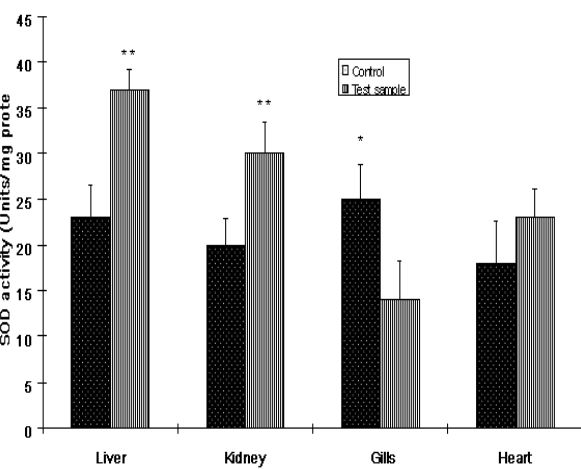
Figure 1: The activities of superoxide dismutase (SOD) in the livers, kidney, Gills and heart of Clarias gariepinus from Ogun River and Agodi farm. Values are mean ± SD of 10 fishes. Significantly different from control,* p<0.001;** p<0.01